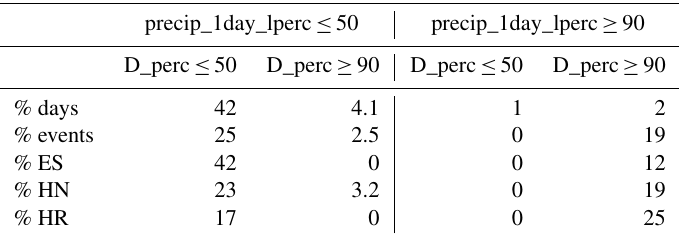
Table 2. Percentage of days with combinations of precip_1day_lperc and D _perc percentiles below 50 or above 90 (days). Percentage of rockfall events occurring for these percentile combinations is specified for all events (events) and separately for the events belonging to the clusters ES, HN and